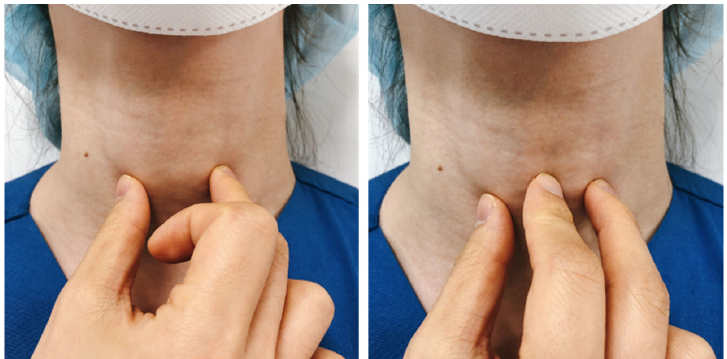
Figure 3. Identifying the cricothyroid membrane by digital palpation.